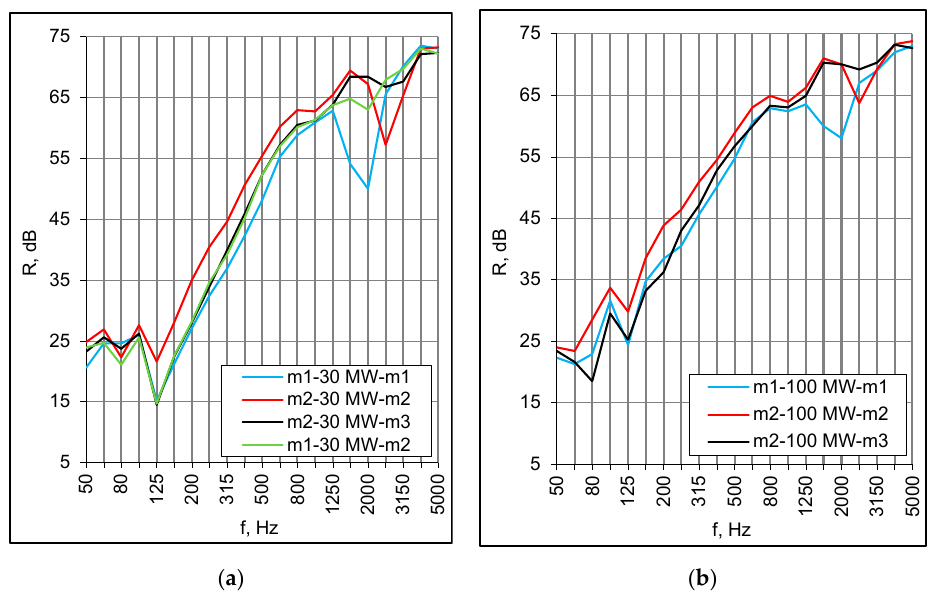
Figure 4. ( a ) Sound reduction index of double set-ups with 30 mm cavity filled with mineral wool (MW), small samples; ( b ) Sound insulation of double set-ups with 100 mm cavity filled with mineral wool (MW), small samples.